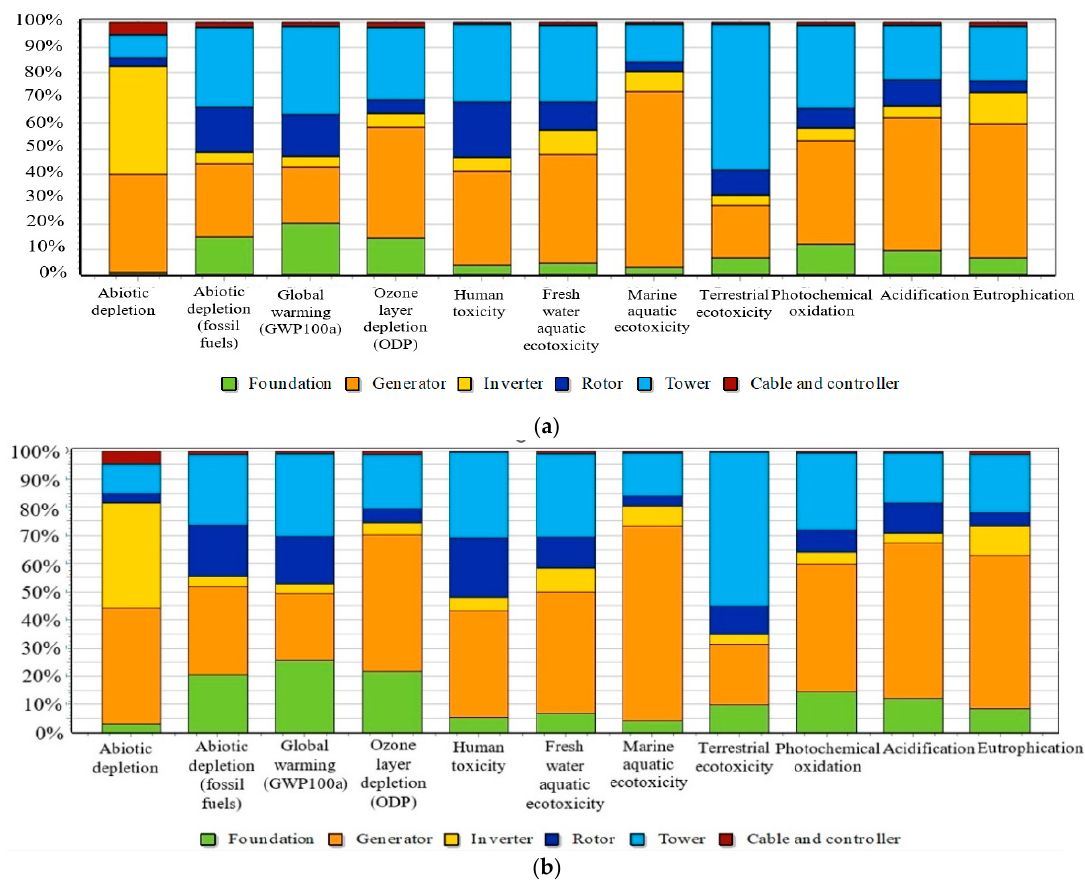
Figure 5. ( a ) Environmental impacts of the VAWT per component (Surat Thani); ( b ) environmental impacts of the VAWT per component (Chiang Mai). Table 7. Component contribution (%) to impacts.